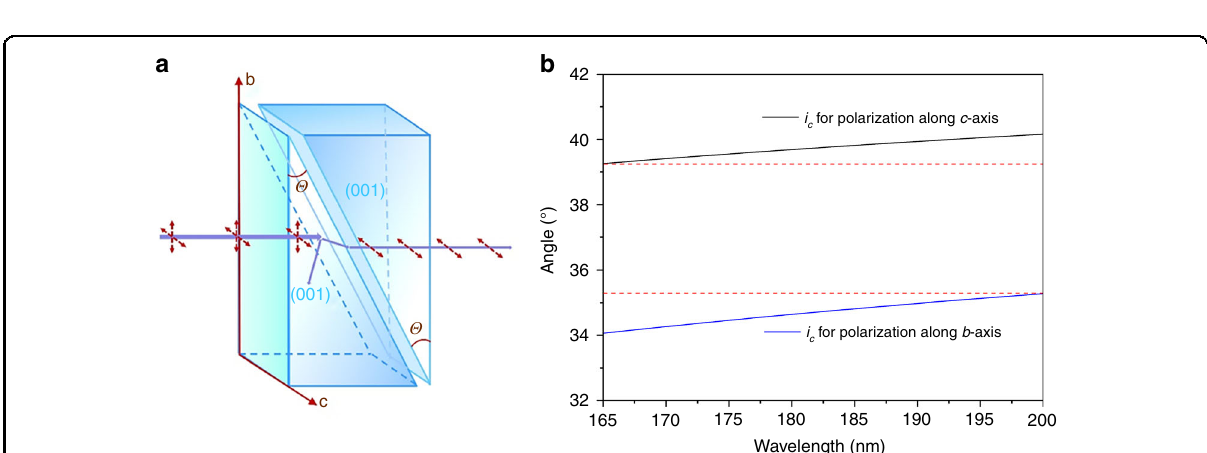
Fig. 3 A design of optical polarization device based on LiBO 2 crystal. a Schematic design of Glan-type polarizer based on LiBO 2 crystal. b Critical angle of total internal re fl ection ( i c ) for polarization along b - and c -axes of LiBO 2 in a wavelength ranging from 165 to 200 nm